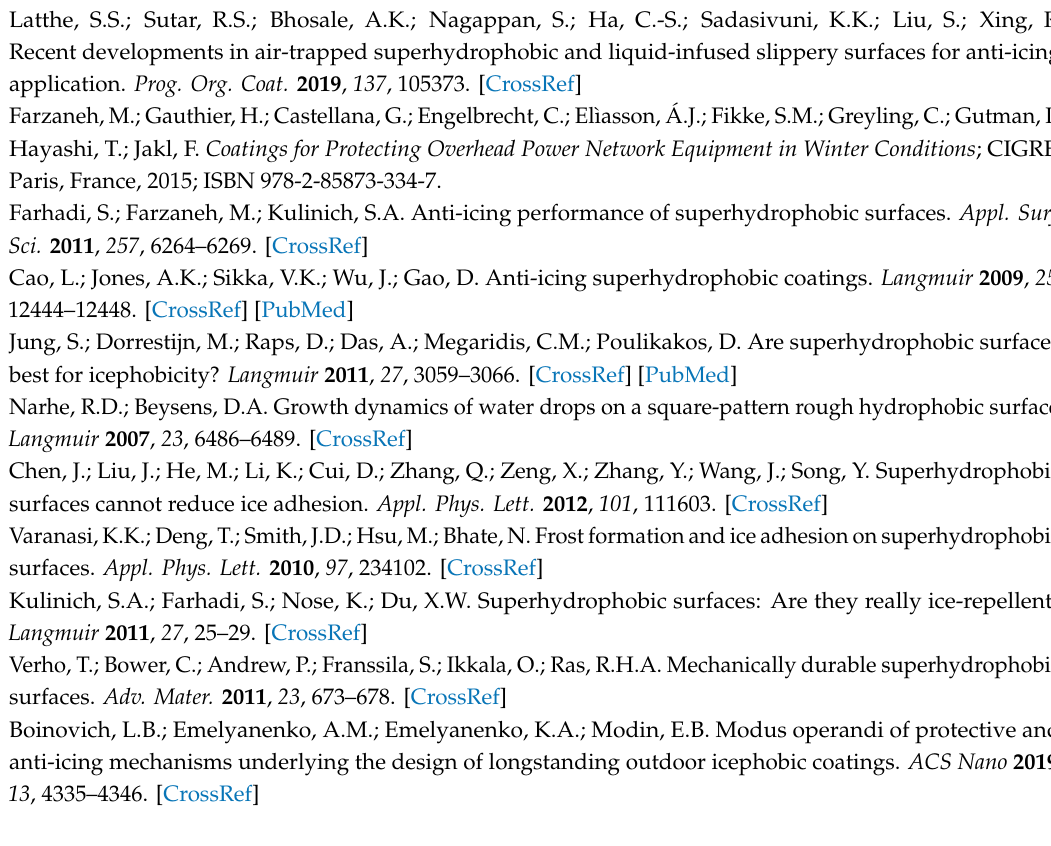
Figure S1: home-made equipment for shear stress measures, Table S1: Protocol for shear stress measures, Figure S2: sample treatment protocol for the durability testing in wet chemicals, Table S2: Schedule of the wettability measures after the immersion in wet chemicals, Figure S3: durability in acid solution: static contact angles, Figure S4: durability in acid solution: hysteresis, Figure S5: durability in acid solution: roll-o ff and sliding angles. Figure S6: durability in saline solution: static contact angles, Figure S7: durability in saline solution: hysteresis angles, Figure S8: durability in saline solution: roll-o ff and sliding